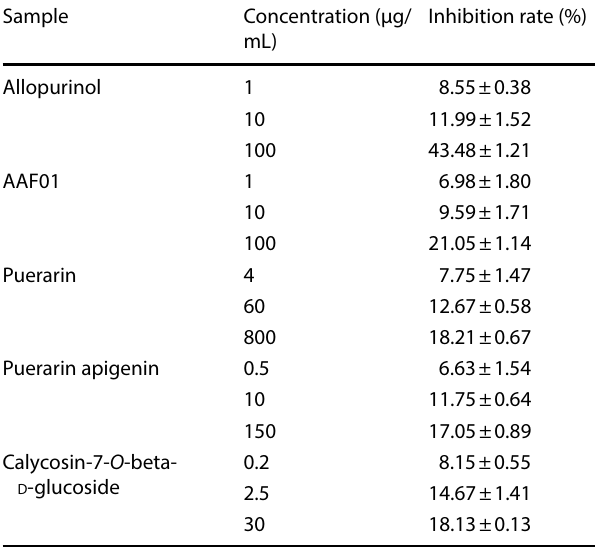
Table 5 Data for linear regression of standard curves for reference compounds Material Regression equation Table 6 The xanthine oxidase inhibition activities of interested compounds